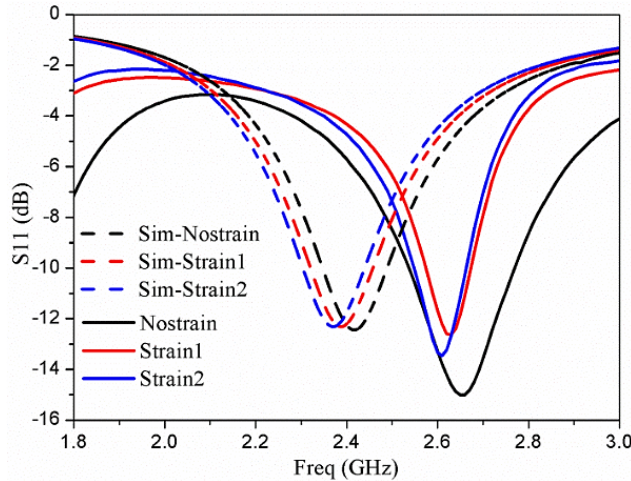
Figure 12. Results of measurements and simulations of the strain test of the 3D-printed strain sensor [18].